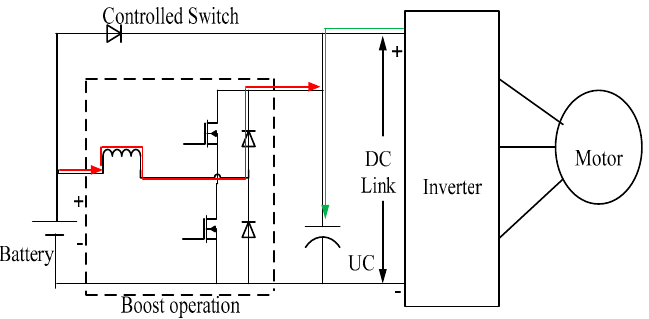
Figure 8. Regenerative braking when V UC < V UC__target .